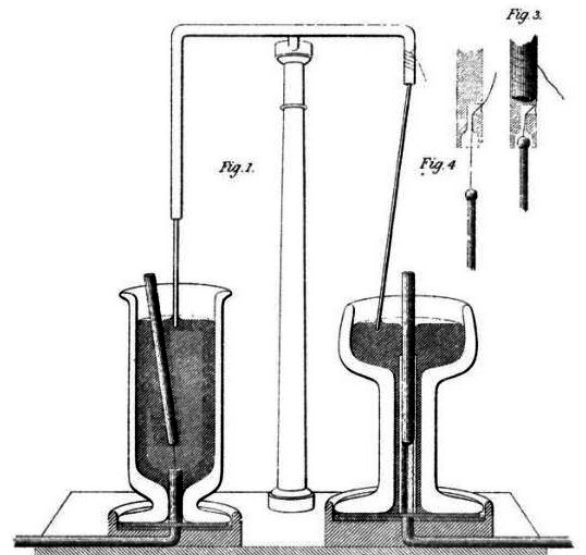
Figure 15. Left: ampoule filled with mercury which is anchored to a movable magnetic rod which rotates to the passage of an electric current along the conductor. Right: ampoule filled with mercury, which contains a fixed magnetic bar around which a conductive wire is crossed by an electric current [17].